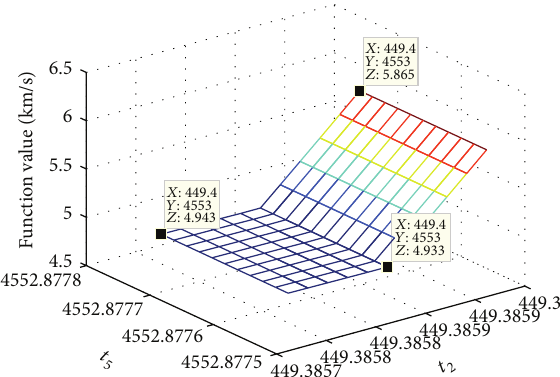
Figure 6: Relationship between function value change and variables 𝑡